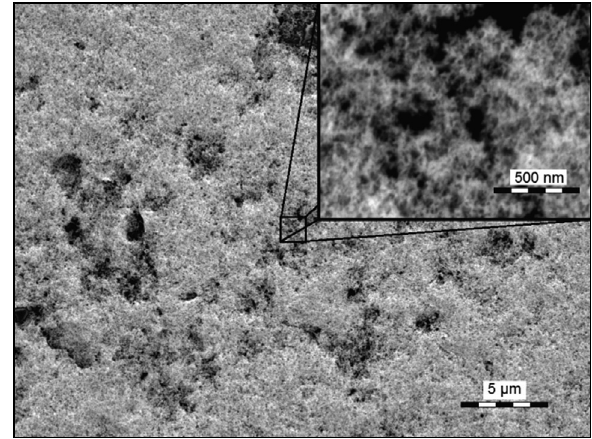
Figure 6. SEM micrographs of Au thin films with 1.0 g m –2 Au (light) on glass (dark) showing features with nano